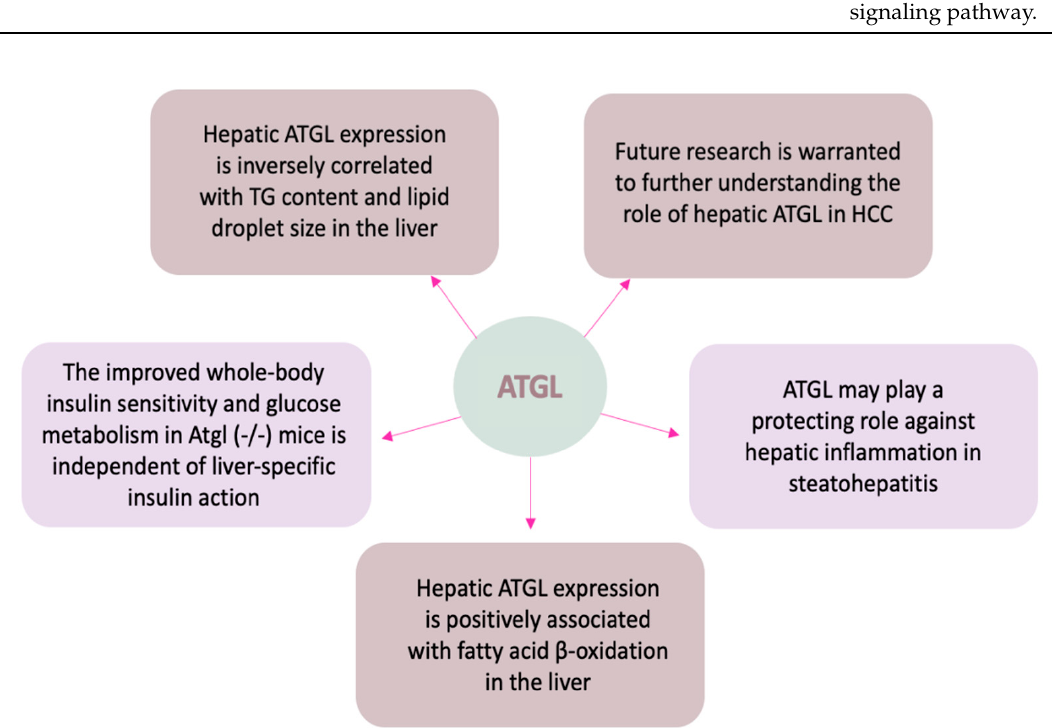
Figure 4. Role of ATGL in regulation of liver pathophysiology. Hepatic ATGL is inversely correlated with TG contents and LD sizes in the liver. Additionally, ATGL-mediated lipolysis provides substrates (FAs) for sustaining FA oxidation and for coordinating the transcriptional program required for FA oxidation. Furthermore, ATGL may play a protective role against inflammatory responses in the liver. Last but not least, although studies have shown that hepatic ATGL is not required for direct systemic glycaemic control, its significance in controlling hepatic and systemic glucose metabolism cannot be excluded considering the mutual coordination of glucose and FAs as major fuels. Table 1. Studies of mouse models with global- and liver-specific mutation of ATGL.